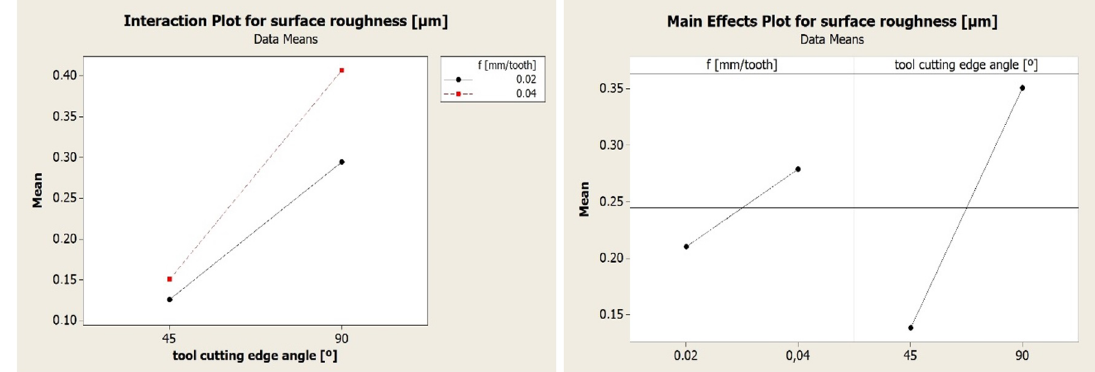
Figure 7. Main effects and interaction plots involving the determining factors for titanium surface